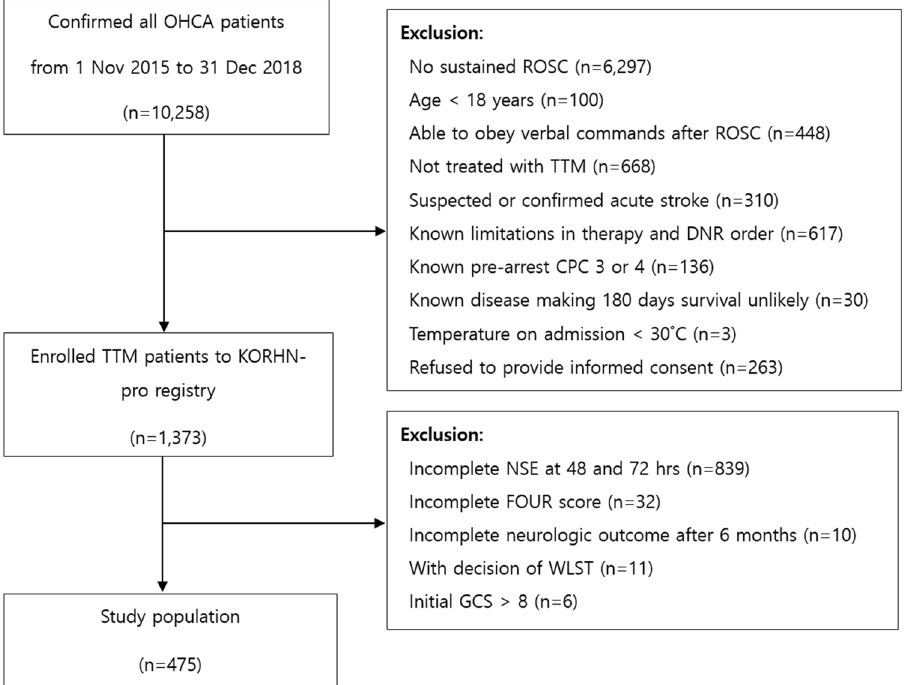
Figure 1. Flow chart depicting the patient selection process. OHCA: out-of-hospital cardiac arrest; ROSC: return of spontaneous circulation; TTM: targeted temperature management; DNR: do not resuscitate; CPC: cerebral performance category; NSE: neuron-specific enolase; FOUR: Full Outline of UnResponsiveness; WLST: withdrawal of life-sustaining therapy; GCS: Glasgow Coma